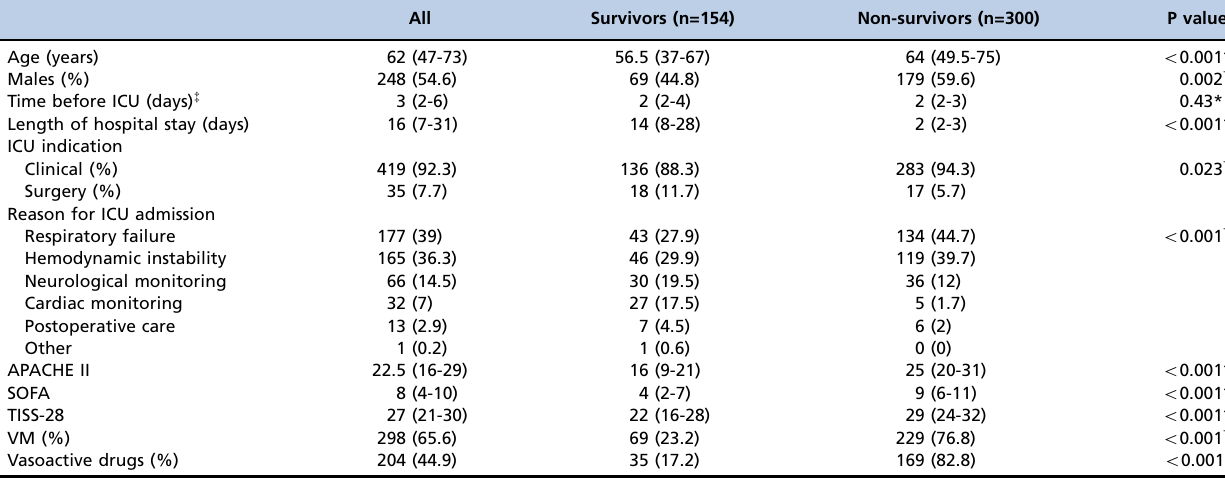
Table 1 - Demographic and clinical characteristics of the study